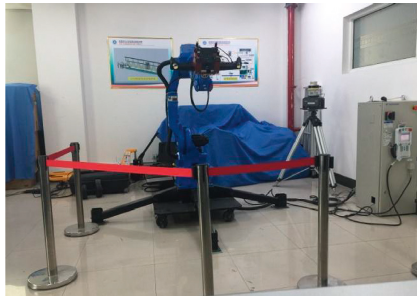
Figure 23: 3D shape measurement system based on robot.